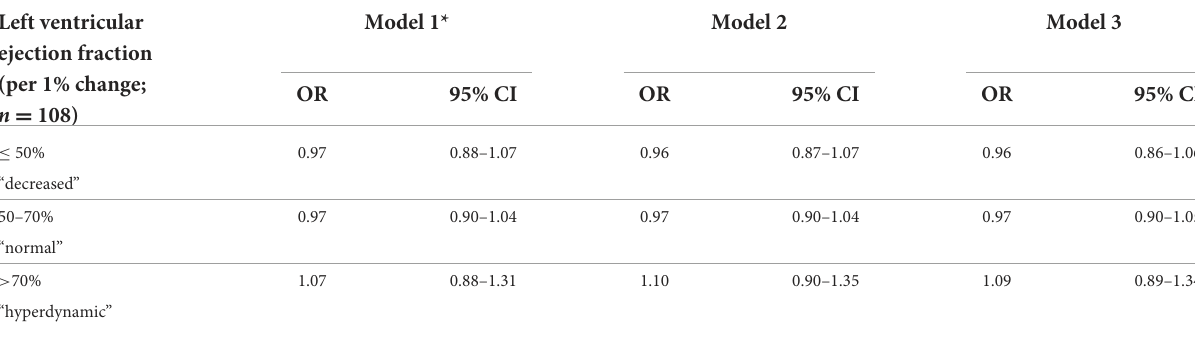
TABLE 3 Logistic regression analysis demonstrating the odds of scoring in the high SIS category per unit change within the specified LVEF range among stroke